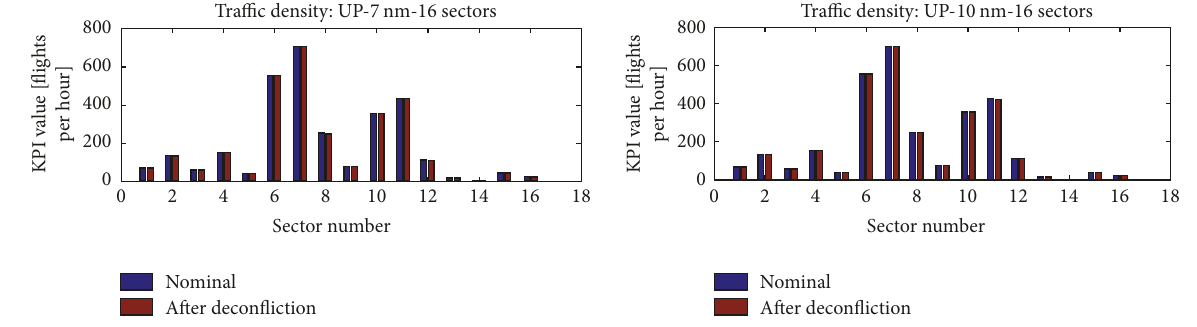
Figure 6: Traffic density per sector in the analysis cases of 7 NM/16 sectors and 10NM/16 sectors.